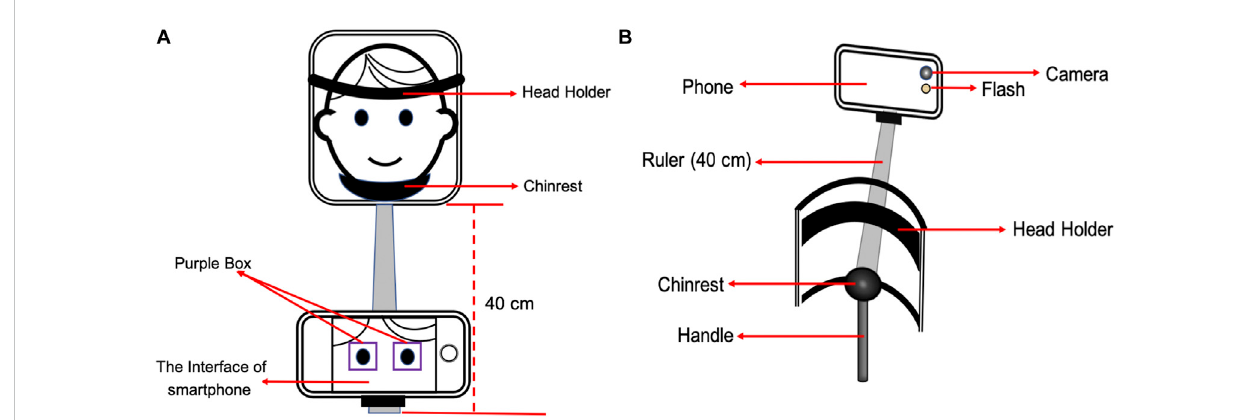
FIGURE 1 Thedevicewasmadeto fi xthesmartphoneonthesamelocationat40 cmfromtheface.Subjectswereaskedtoholdthedeviceandfocusedonthe camera fl ash during the whole process, putting the chin on the chinrest and sticking the forehead to the head holder (A, B) . A pair of purple boxes were plotted on the screen to help guide positioning without head rotation (A) .